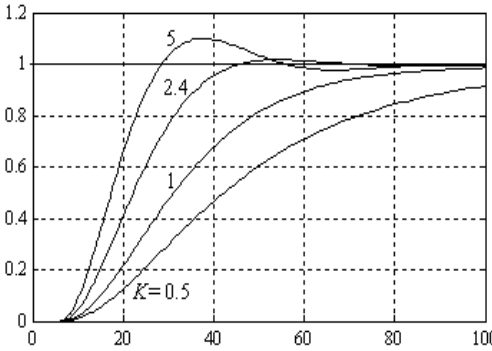
Figure 10. Responses y ( t ) to a unit step reference for K = 0.5; 1; 2.4; 5.